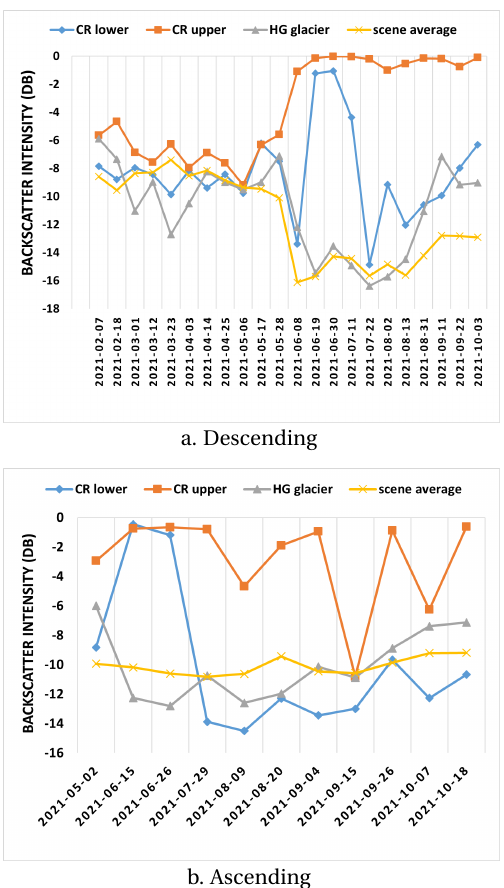
Figure 9. Backscatter coefficient time series for PAZ images.